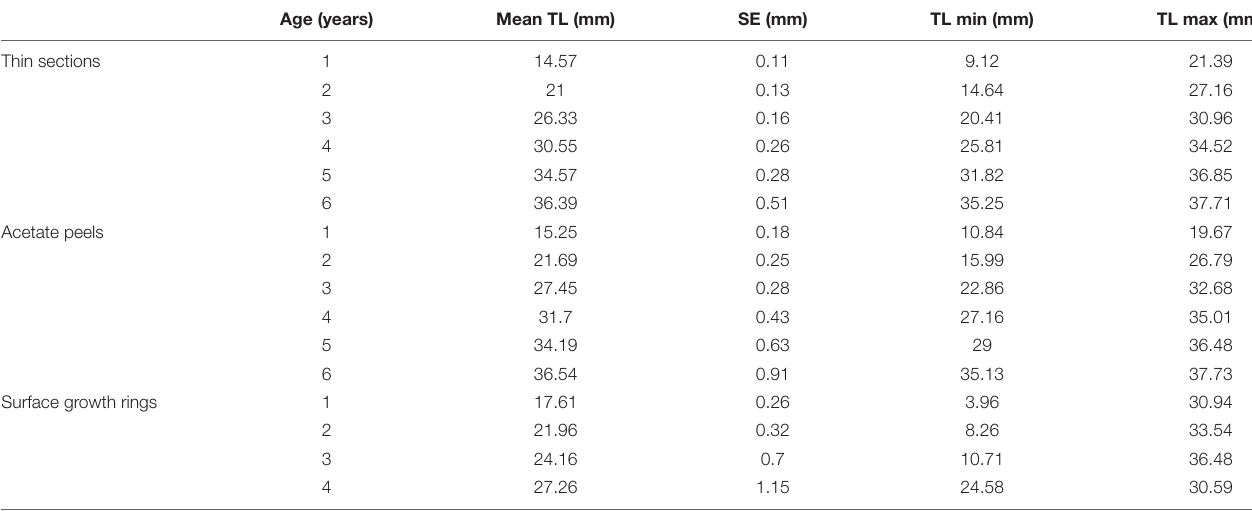
TABLE 1 | Maximum, minimum and mean length-at-age and respective SE of C. gallina specimens from the mid-western Adriatic Sea calculated with the three aging techniques.